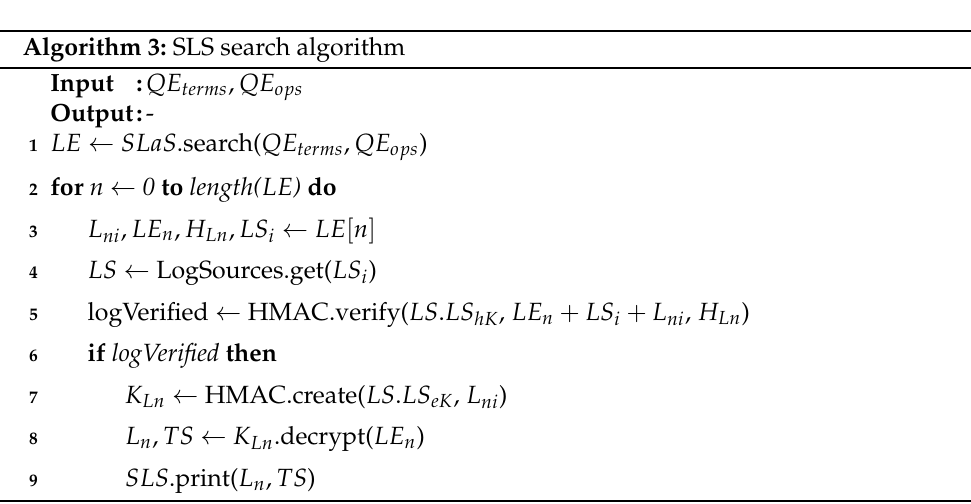
Algorithm 3: SLS search